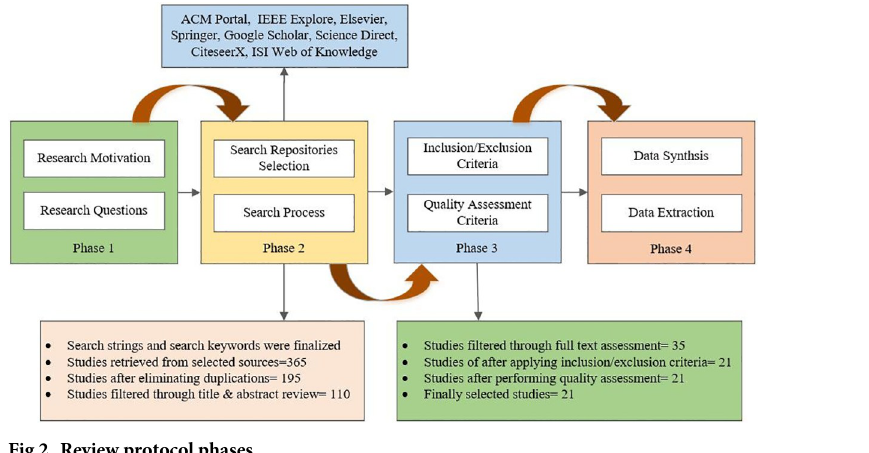
Fig 2. Review protocol